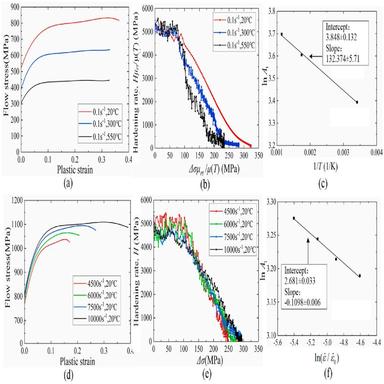
Experimental and analysis results in compression tests. (a)–(c) The stress-strain curves, hardening rate curves, and ln A1-1/T curve under deformation at different temperatures at 0.1 s − 1 (d)–(f) The stress-strain curves, hardening rate curves and ln A1-ln (ε˙ /ε˙0) curve under deformation at differernt strain rates at 20 ◦C. The legends in Fig. 8c,f indicate the slope and intercept of the fitted lines.